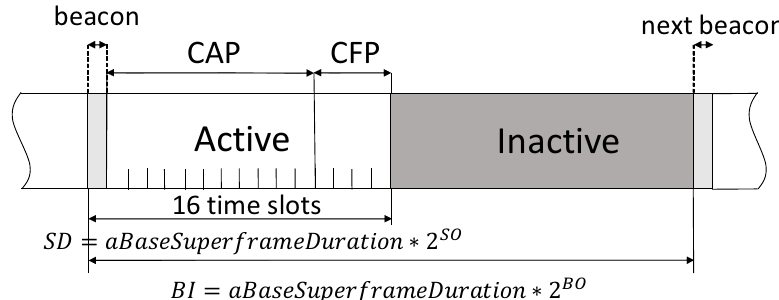
Figure 1. The superframe structure of IEEE